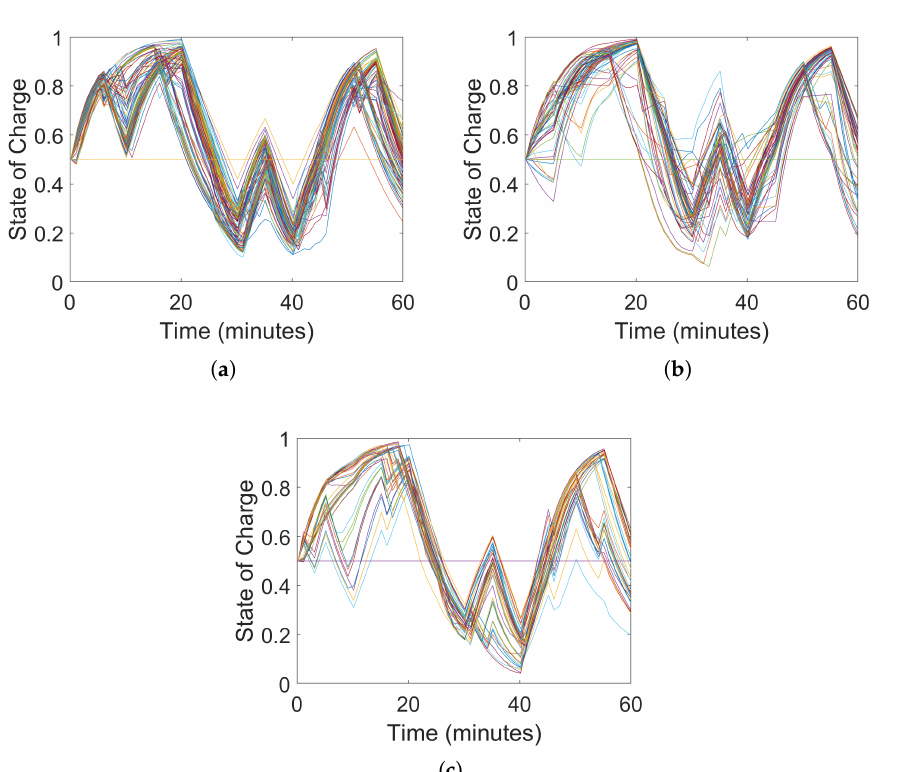
Figure 19. Evolution of the VBs’ normalized state of charge during peak hour in the FOL. ( a ) Feeder 1. ( b ) Feeder 2. ( c ) Feeder